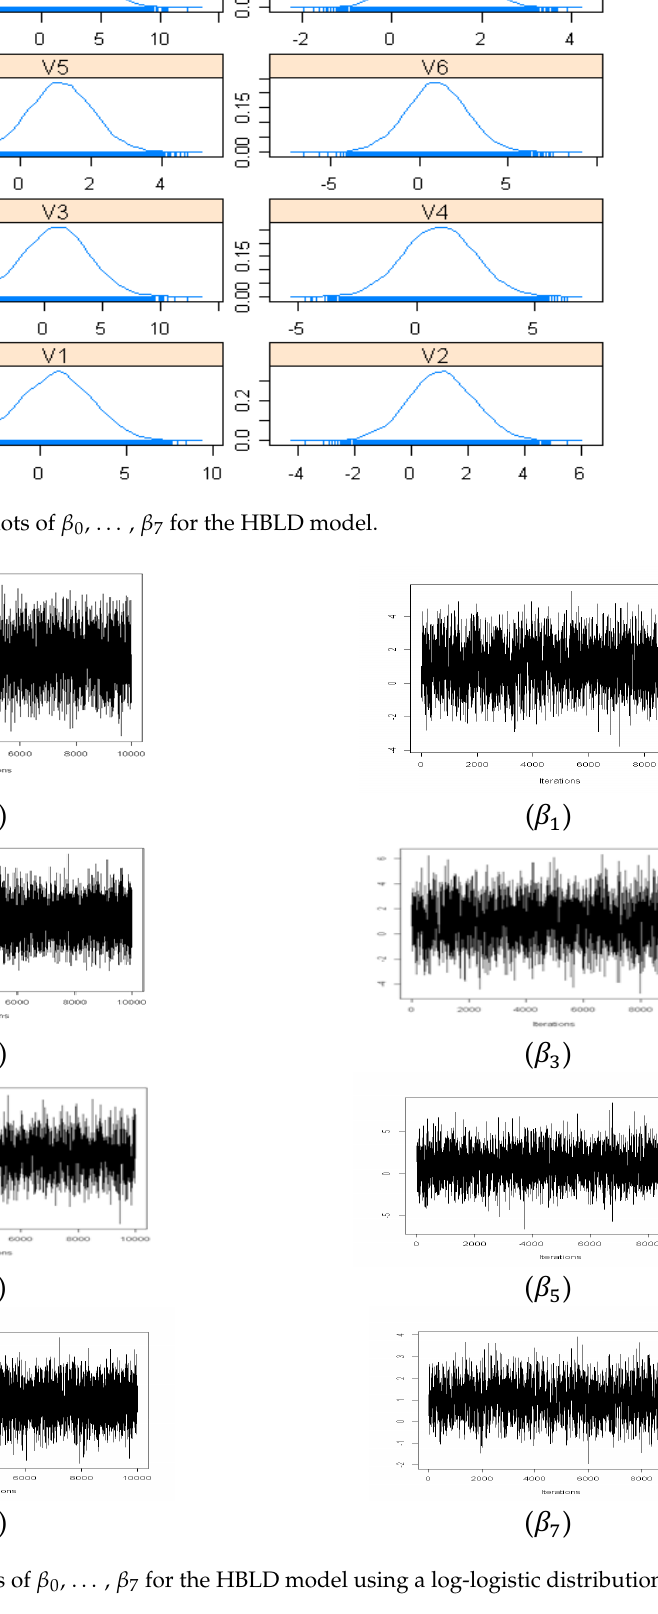
(cid:2870) is a log-logistic distribution. The trace plot of (cid:2870) is displayed in Figure 10. This figure shows that the chains of (cid:2870) mixed relatively well with small fluctuations, confirming the convergence. In addition, the acceptance rate for (cid:2870) is 44%, indicating that the chain moves rapidly across the whole distribution without getting stuck in any one place.